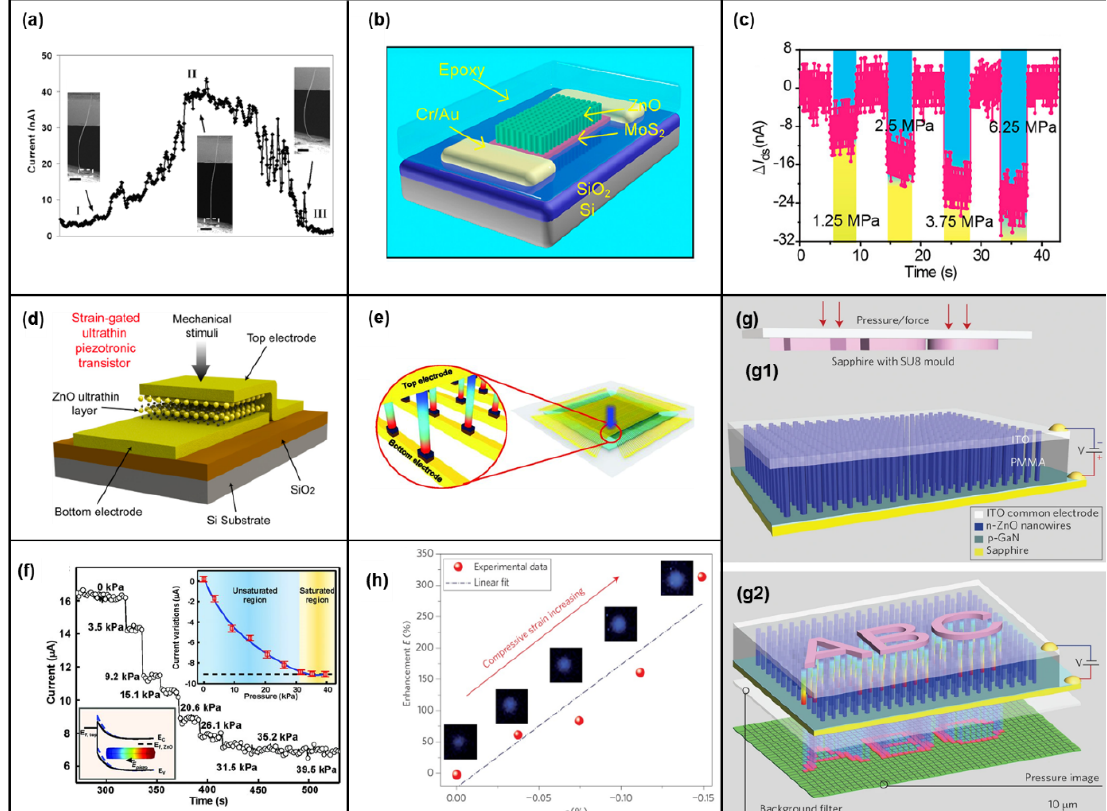
Figure 3. ( a ) The current value of the voltage-controlled NW transistor under the action of differ- ent forces. Reproduced with permission from [42]. Copyright (2006) Nano Letters . Structure and piezoelectric characteristics of pressure-gated field-effect transistors based on 2D MoS 2. ( b ) Device structure. ( c ) Change of drain current at different pressures. Reproduced with permission from [115].